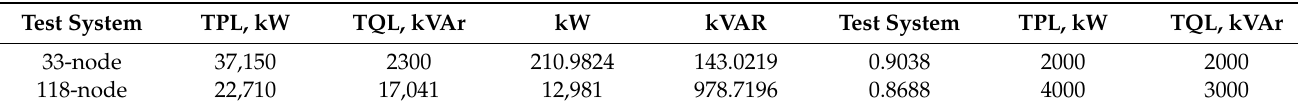
Table 2. Description of test systems and devices.